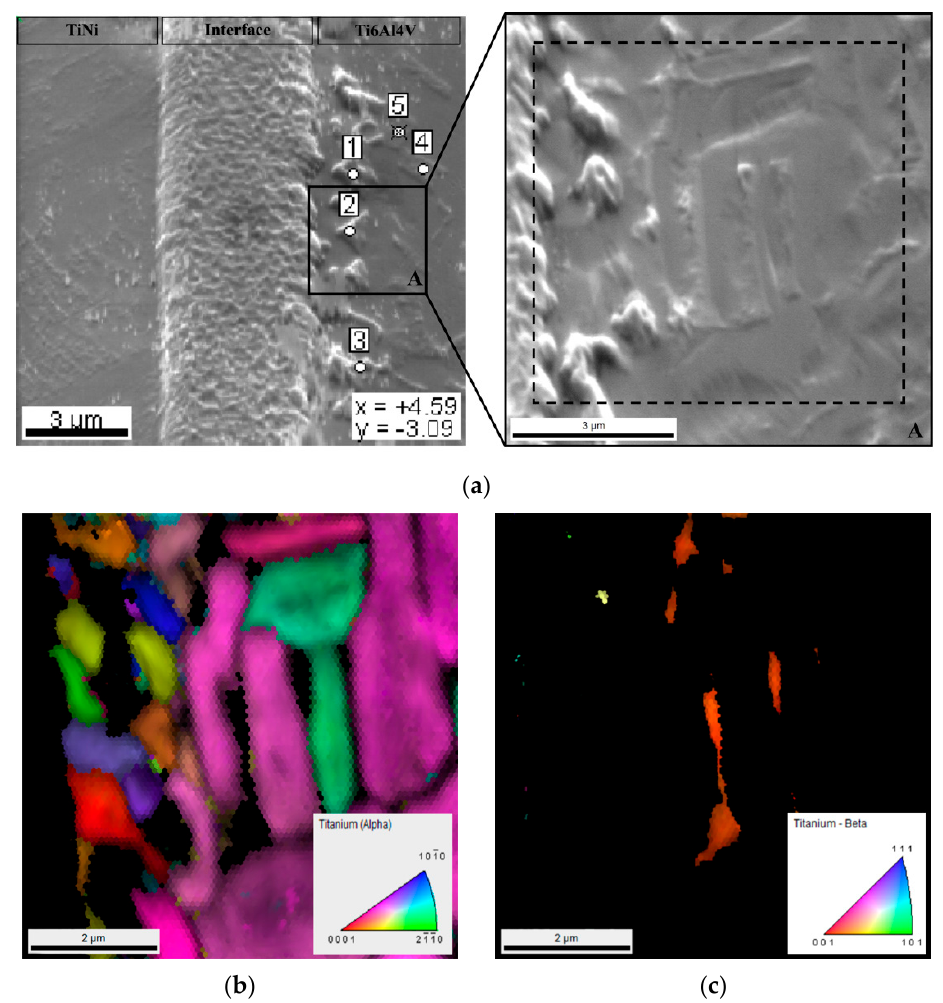
Figure 8. ( a ) SEM image of the TiNi/Ti6Al4V joint and orientation imaging microscopy (OIM) maps of ( b ) α -Ti and ( c ) β -Ti phases.